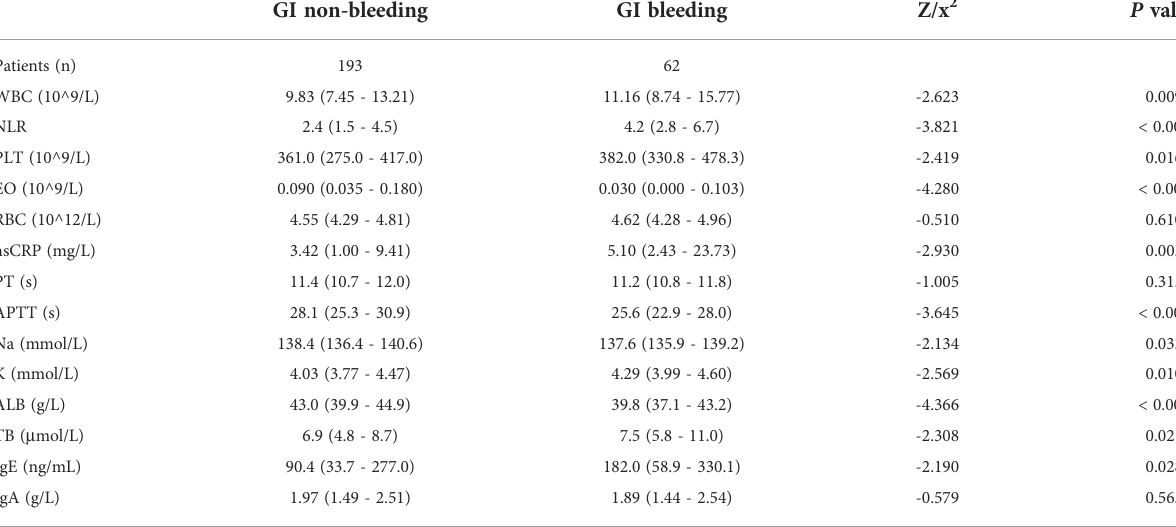
TABLE 2 Laboratory tests of children in the GI bleeding and GI non-bleeding groups in the training set.